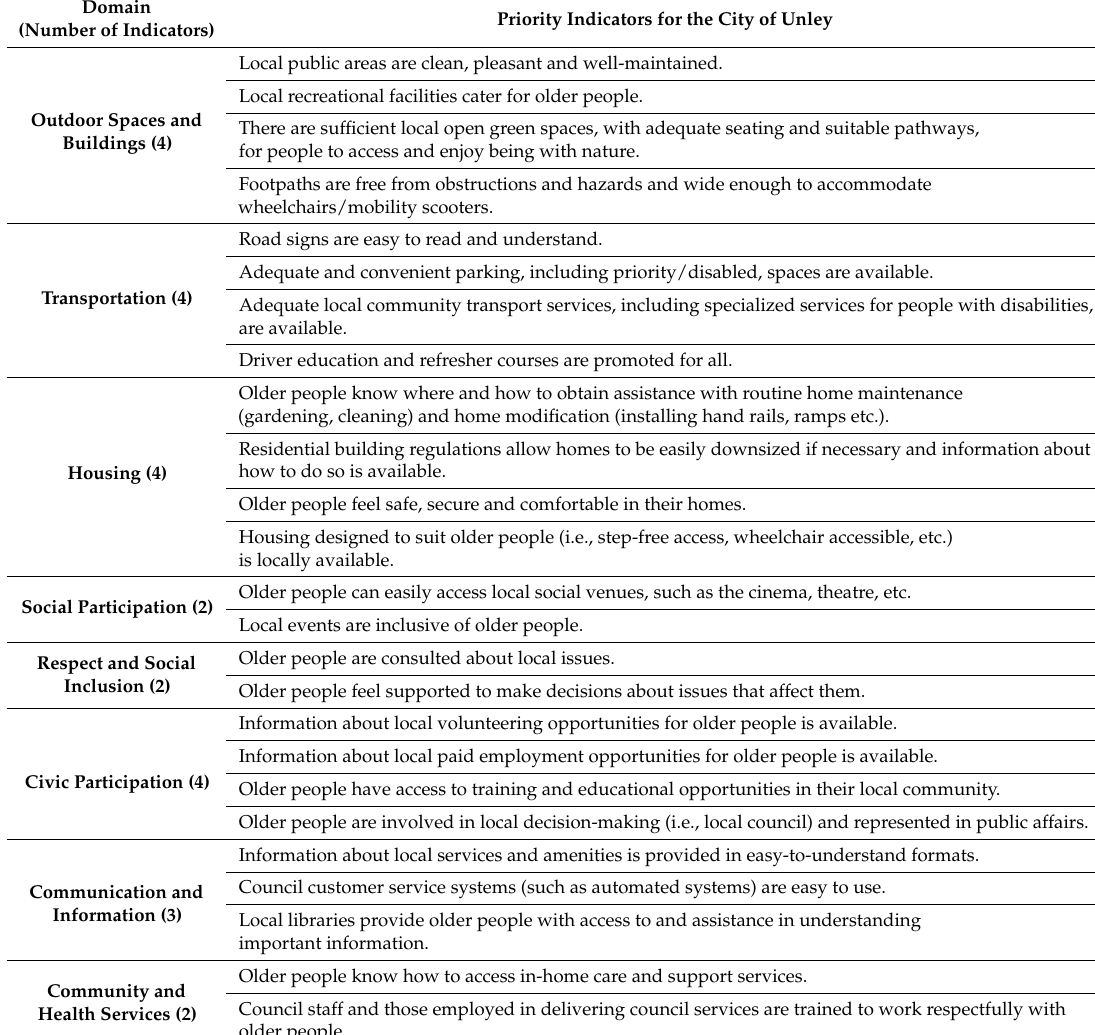
Table 2. Identified priority indicators of age friendly development at the City of